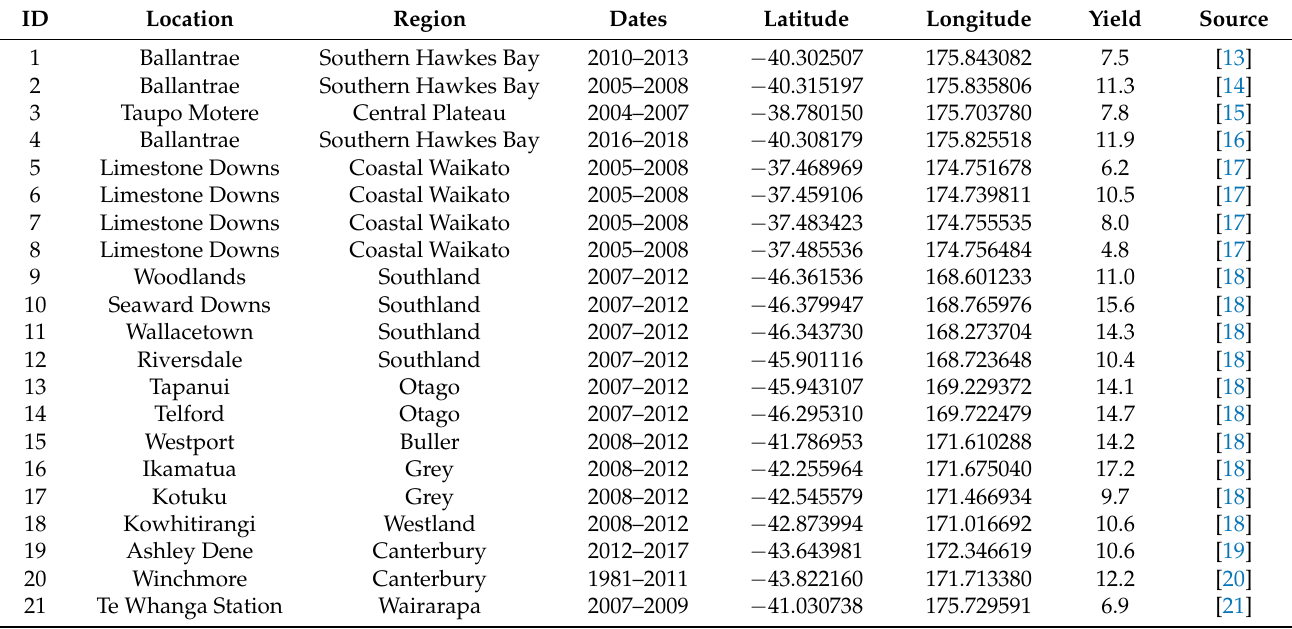
Table 1. Sites of measured biomass yield. Yield is recorded in tonnes of dry matter per hectare, per year